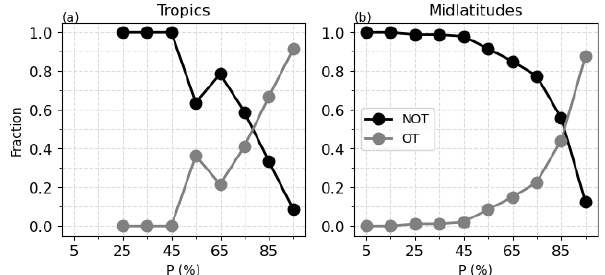
Figure 6. Fraction of OT candidates with a wide range of proba- bility in the tropics (a) and midlatitudes (b) . The x axis shows a probability interval of